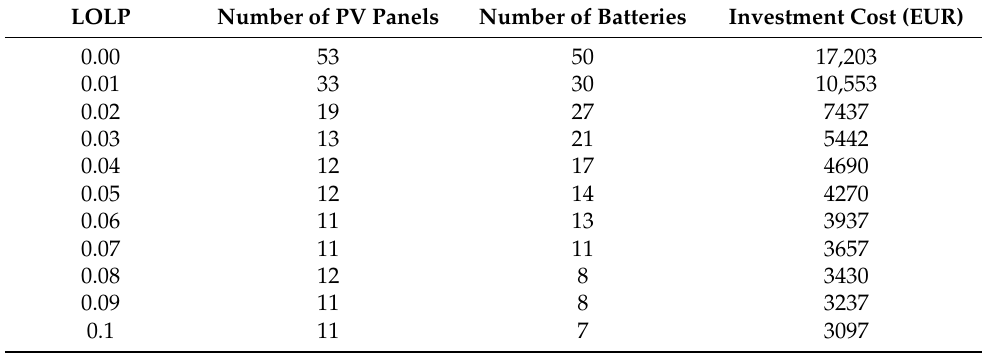
Table 4. System with PV modules and batteries regarding LOLP and investment cost. LOLP Number of PV Panels Number of Batteries